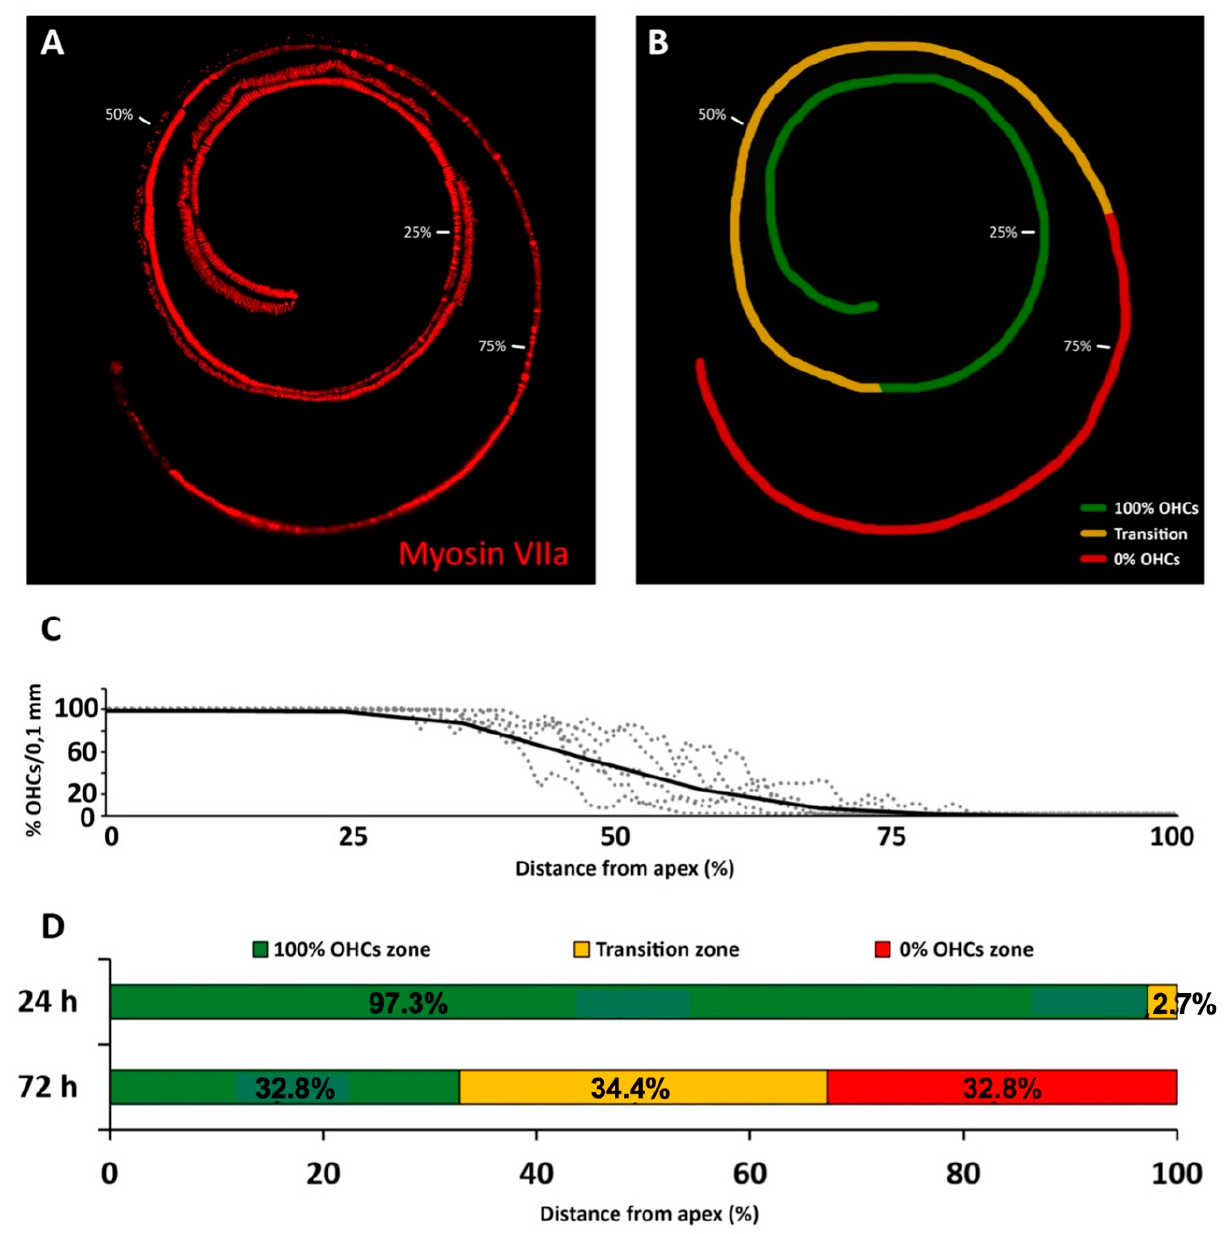
Figure 4. ( A ): Reconstruction of a representative cochlear spiral, immunostained by immunofluores- cence with myosin VIIa, from the cochlea of a rat treated with a single injection of cisplatin (16 mg/kg bw) at 72 h after administration of the drug. ( B ): Color-coded schematic representation of the cochlear spiral in ( A ). The segment with complete preservation of OHCs, the transition zone and the zone with complete loss of OHCs are shown, respectively, in green, yellow and red. Percent values in ( A , B ) indicate relative cochlear distance starting at the apex. ( C ): OHC counts from surface preparations at the end of treatment with cisplatin, at 72 h. The percentage of OHC loss/0.1 mm length is charted along the complete extension of the organ of Corti. Each dotted line is an individual animal. The solid line is the average. ( D ): Temporal and spatial sequence of OHC loss with cisplatin. Changes with time after treatment represented as the mean percentage of the length of the organ of Corti occupied by the zone with full preservation of OHCs (green), the transition zone (yellow) and the zone with complete loss of OHCs (red) in rats treated with cisplatin, 24 and 72 h after initiation of